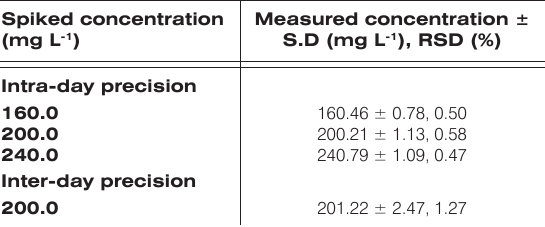
Table 1. Intra-day and inter-day precision (n = 6 ) studies.